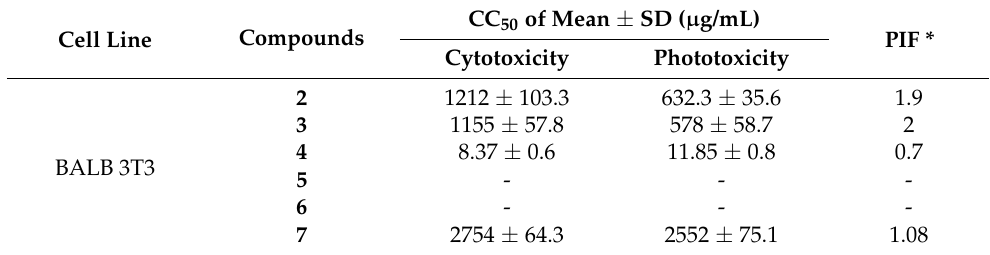
Table 1. Cyto- and phototoxicity assay data. Cell Line